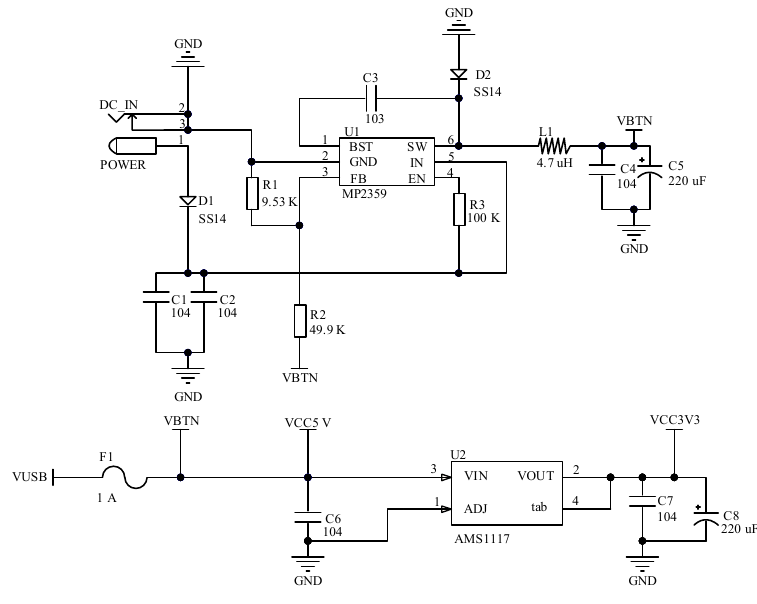
Figure 3. Power supply circuit.